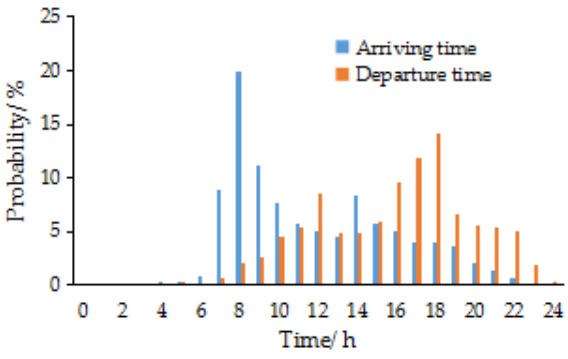
Figure 5. Probability distribution of arrival time and departure time.